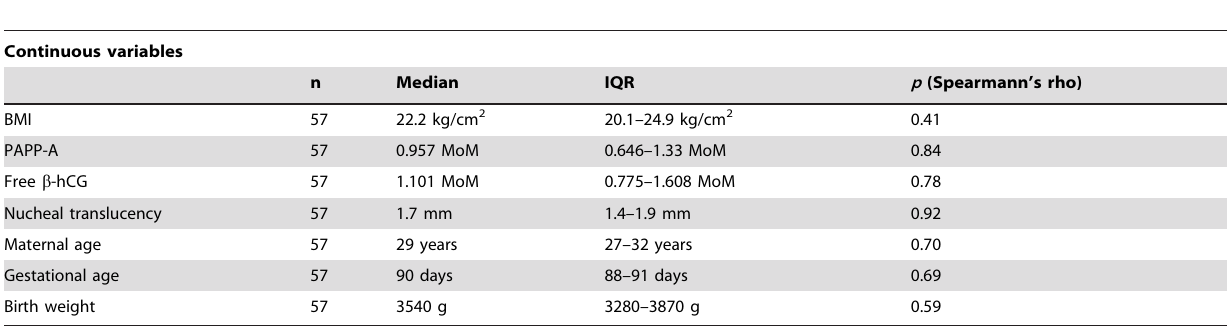
Table 1. The median and 25–75th percentile of different continuous variables and their correlation isolated fetal cells in 30 ml maternal blood.